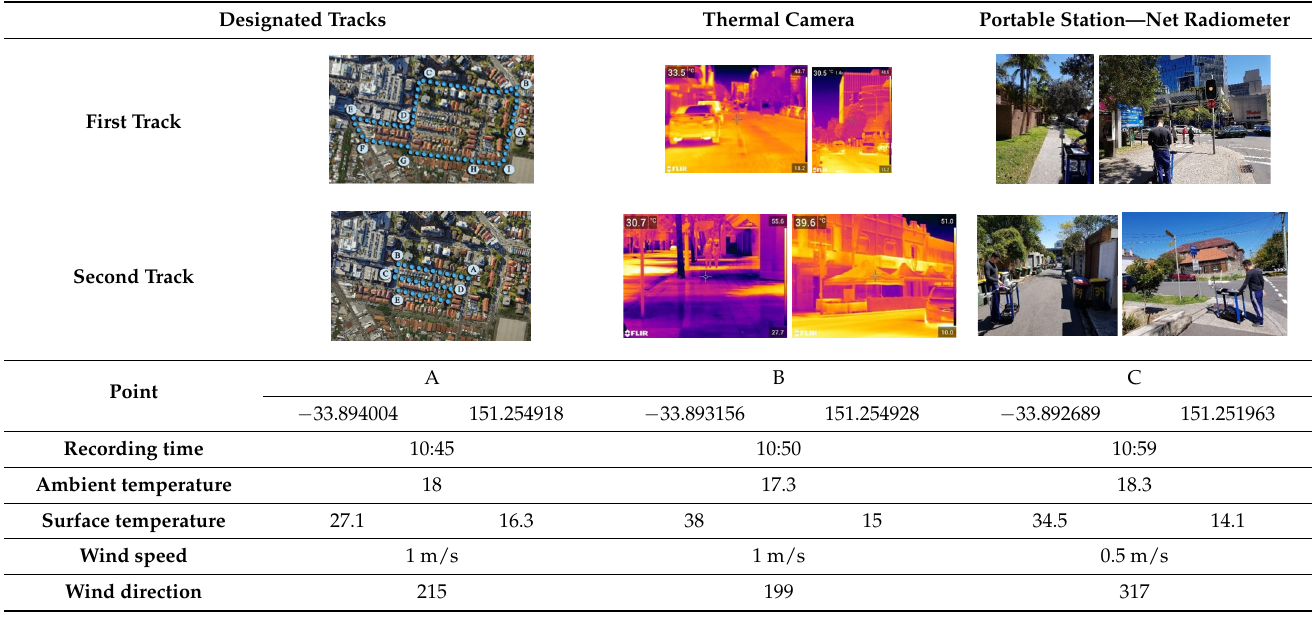
Table 5. Designated tracks, a sample of the thermal camera pictures, and measured variables with their corresponding points.